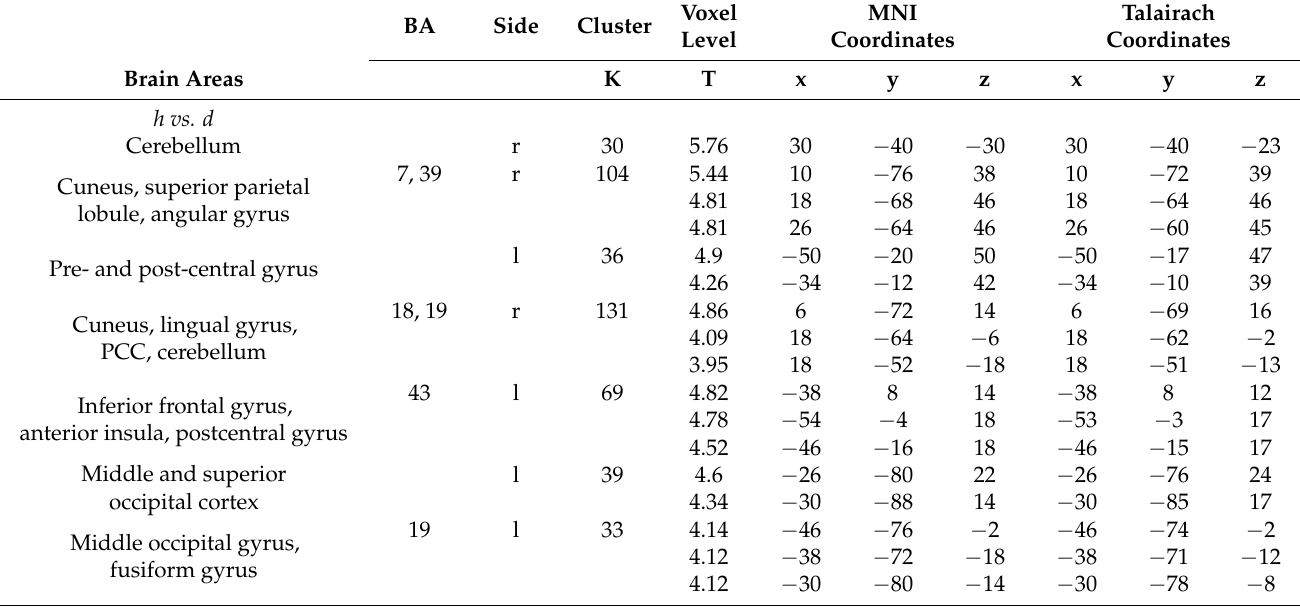
Table 4. Peak coordinates of positive correlation with the personal distress subscale.